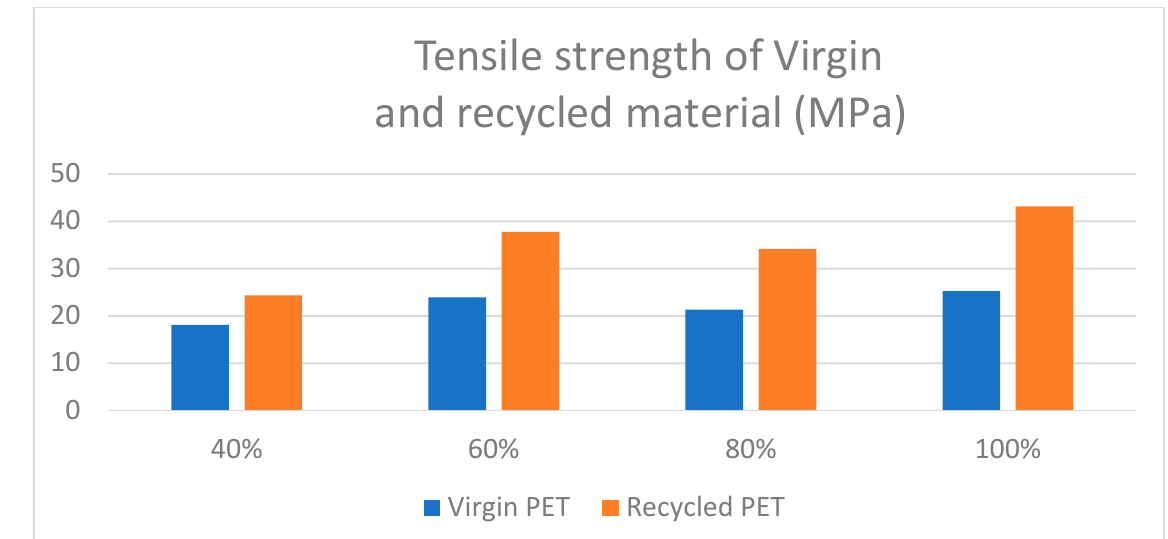
Figure 6. Tensile strength of a recycled and virgin 3D printed PET.